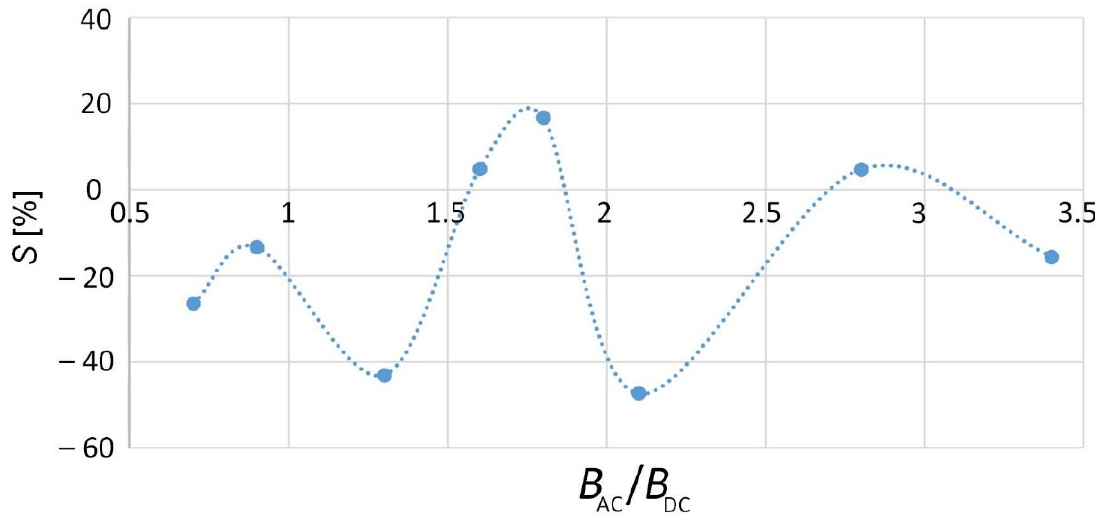
Figure 11. Dependence of the response rate parameter of a biological system on the change in the induction ratio, sample C.